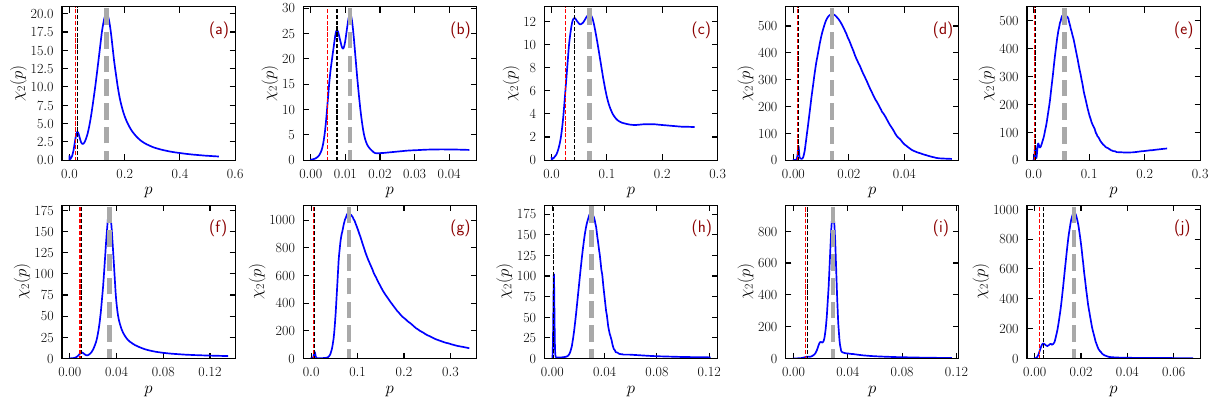
Figure 5. Susceptibility plots for networks exhibiting a secondary peak on the left. Numerical bond percolation susceptibility for the networks ( a ): GR-QC, 1993-2003 ; ( b ): Reactome ; ( c ): PGP ; ( d ): Flickr ; ( e ): Web Stanford ; ( f ): DBLP, collaborations ; ( g ): Web Notre Dame ; ( h ): Zhishi ; ( i ): US Patents ; and ( j ): DBpedia . The global maximum of the susceptibility χ 2 ( p ) , indicating the percolation threshold, is marked by a gray vertical bar. Black vertical lines indicate the position of the secondary peak. Red vertical lines signal the value of the prediction 1 /µ M . Notice that for three of the networks ( Web Stanford , Zhishi and DBpedia ) the NBC is localized on overlapping hubs, while for the others localization occurs on the max